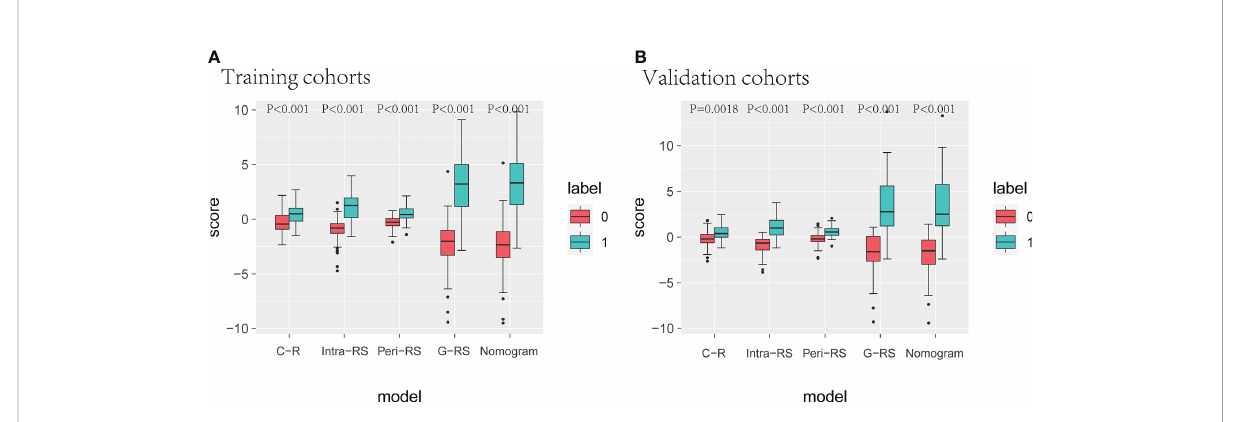
FIGURE 5 Box line plots for different model radscores. (A) (training set), (B) (veri fi cation set), 0 for benign nodules, 1 for lung